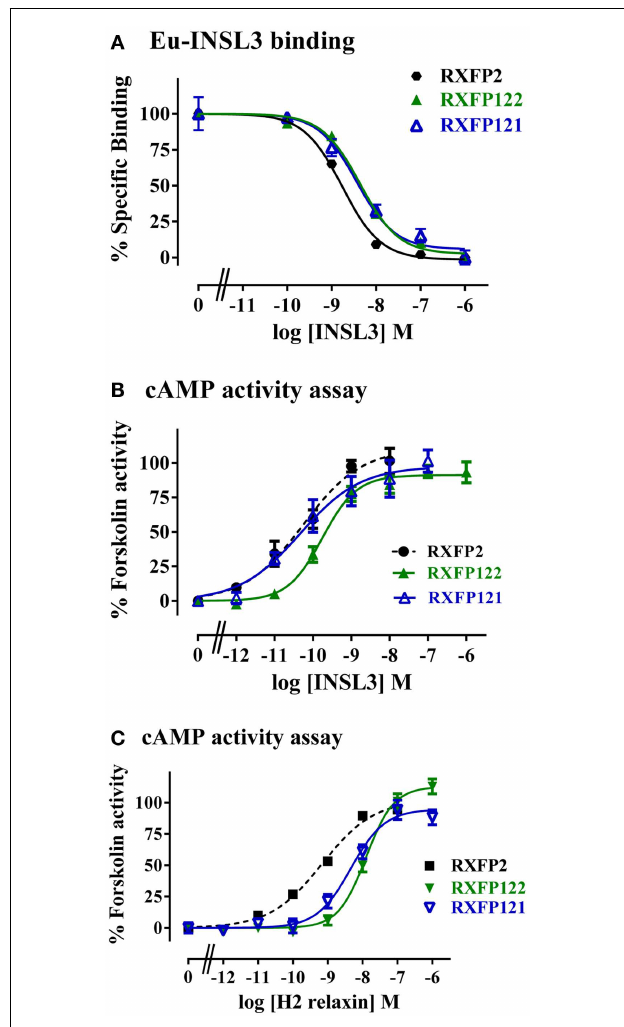
FIGURE 5 |Activity of RXFP2 chimeric receptors compared to RXFP2 . (A) Competition binding using Eu-labeled INSL3. (B) INSL3-induced cAMP responses. (C) H2 relaxin-induced cAMP responses. cAMP activity is expressed as the percentage of the 5 µ M Forskolin-stimulated response for each receptor. Data are expressed as mean ± SEM of triplicate determinations from at least three independent